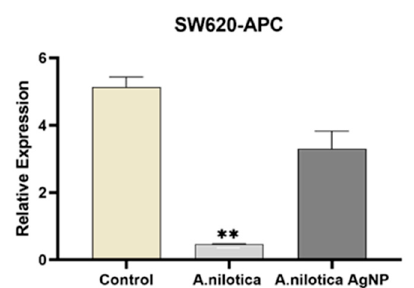
Figure 8. Cytotoxicity of A.nilotica pod extract and its AgNPs on colon cancer cell lines (SW480 and SW620) following 24, 48 and 72 h exposure.